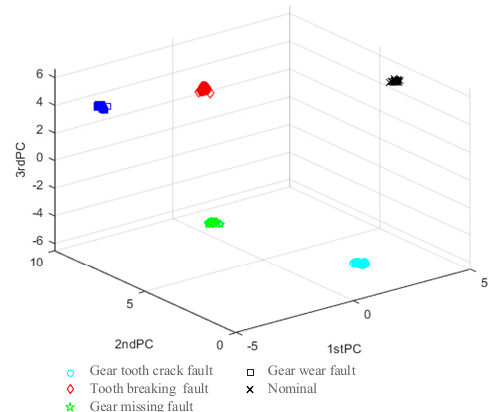
Figure 8. Clustering result of gear fault features under condition 2.